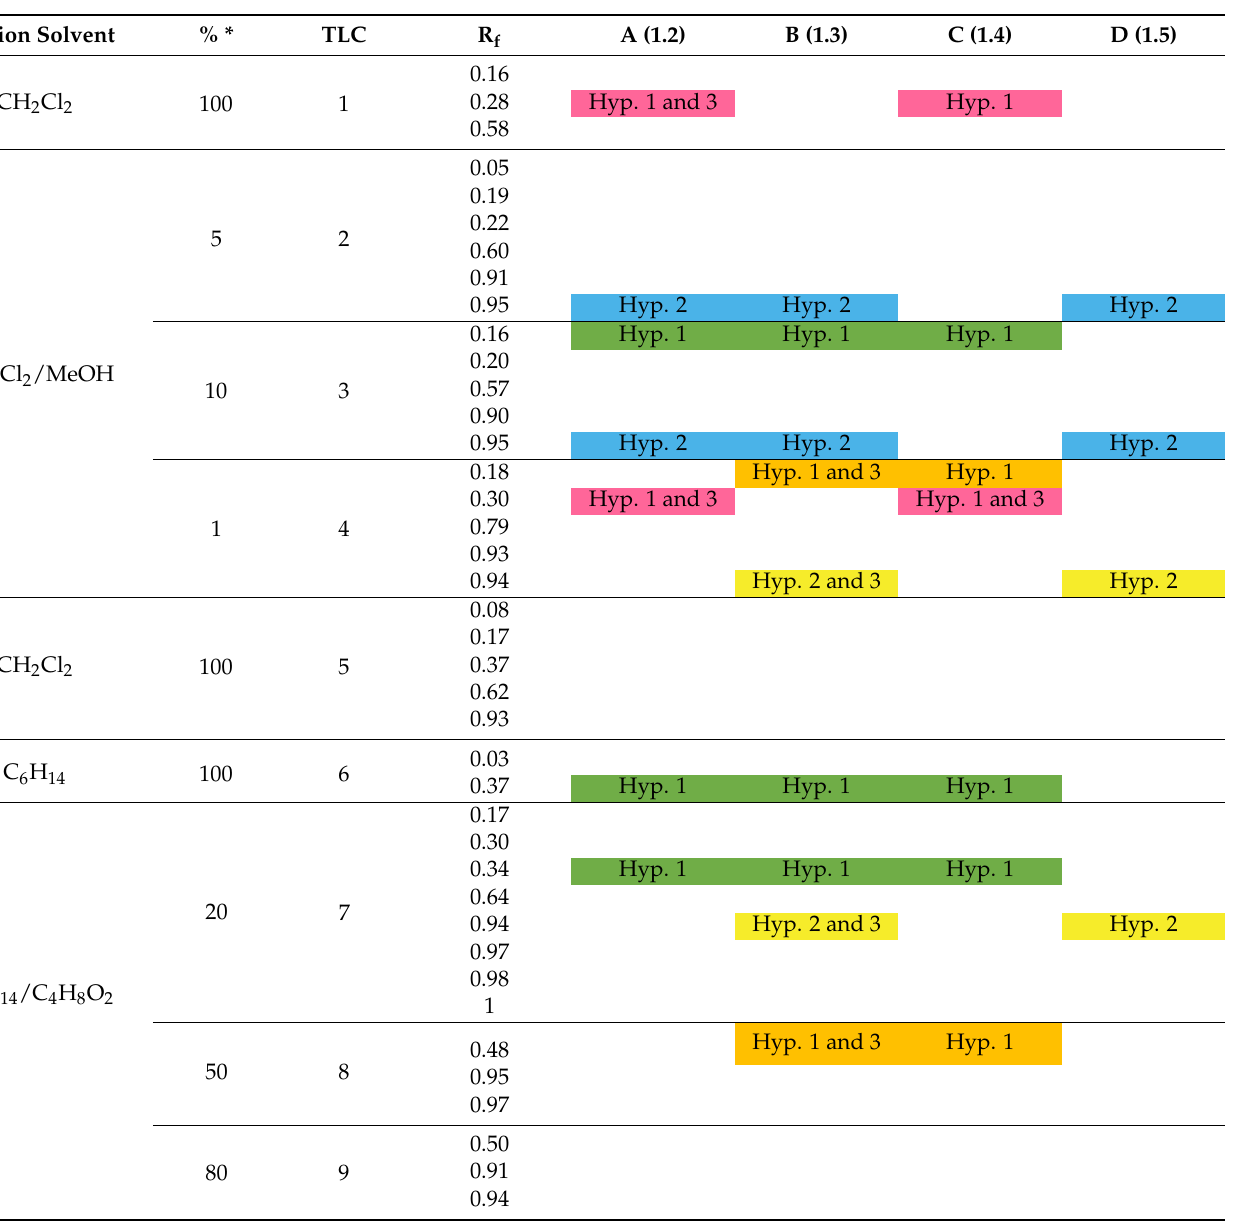
Table 1. Organic phases obtained with TLC results. (A) Healthy A. cathartica leaves, (B) herbivored A. cathartica leaves, (C) caterpillar bodies and (D) caterpillars’ feces. Solvent percentages are presented as highest polarity in solution (MeOH and EtOAc)